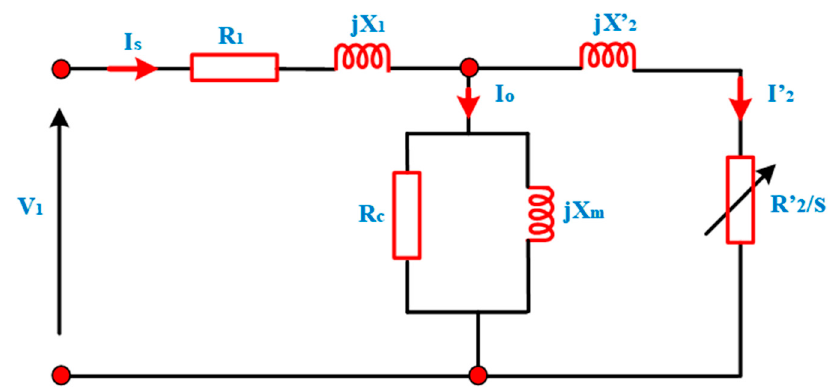
Figure 2. Simplified induction motor equivalent circuit.